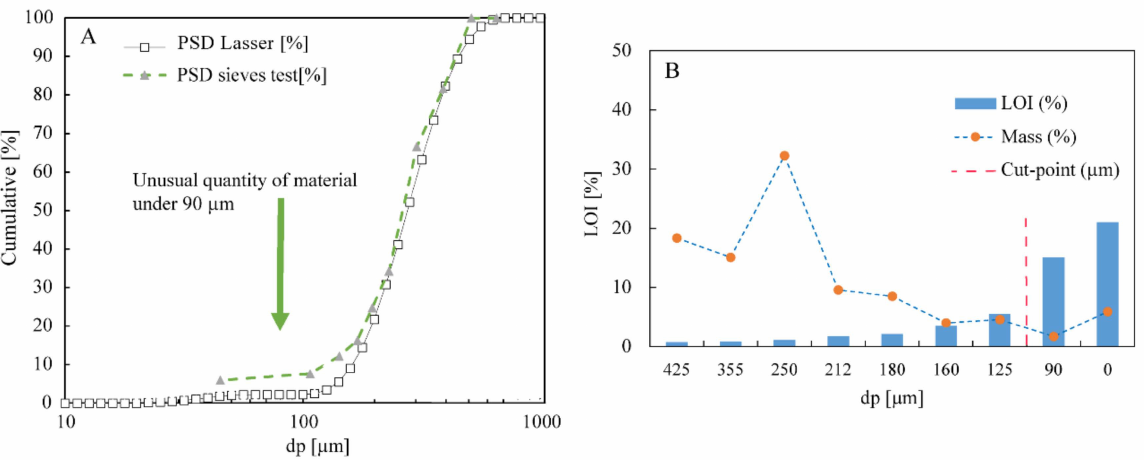
Figure 5. ( A ) Particle size distribution of the initial material resulted from the laser analysis and sieve analysis, where the cumulative mass is plotted against particle diameter, ( B ) LOI (%) content for each particle size range in